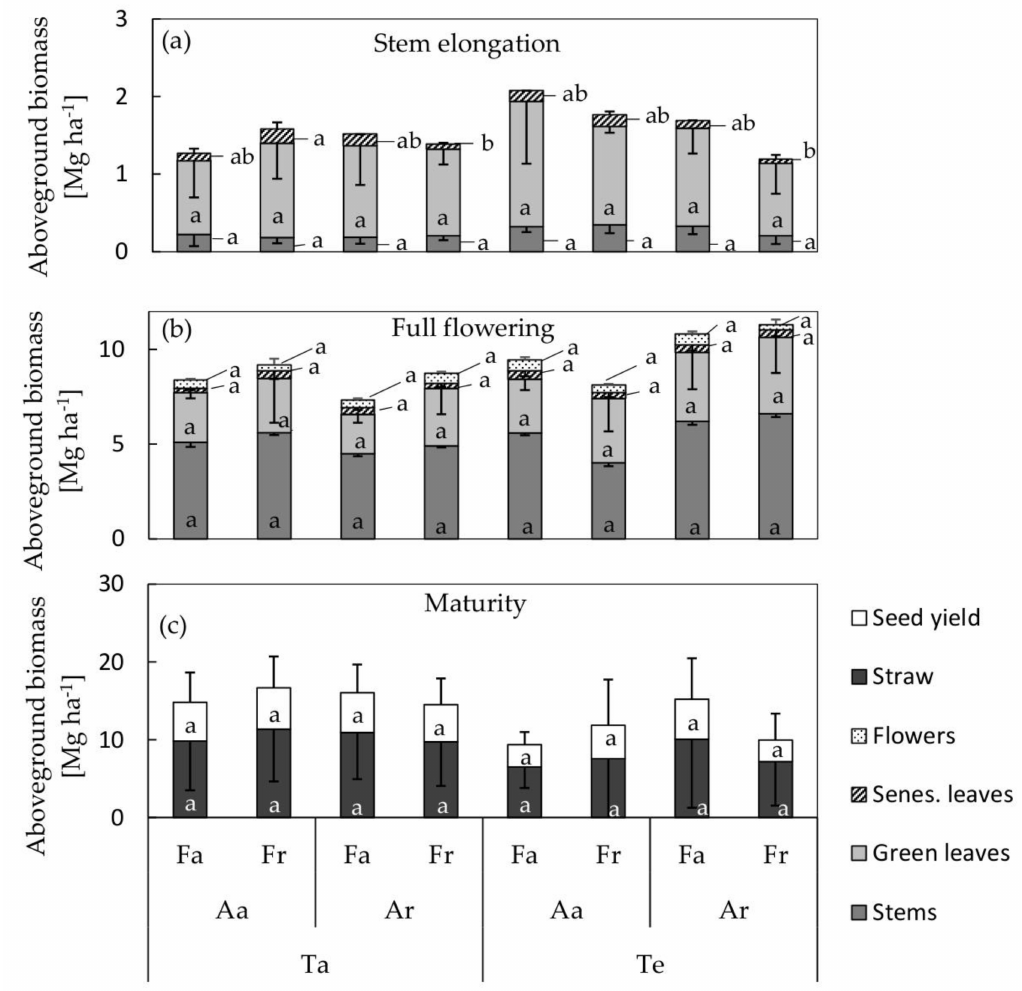
Figure 4. Aboveground biomass of OSR grown under ambient (Ta) or elevated (Te) soil temperature in combination with the following precipitation patterns: ambient (Aa) or reduced (Ar) precipitation amount and ambient (Fa) or reduced (Fr) precipitation frequency. Three harvests were performed: harvest 1 at stem elongation (DC 31) ( a ), harvest 2 at full flowering (DC 65) ( b ), and harvest 3 at maturity (DC 99) ( c ). The aboveground biomass fractions are shown as dry weight. Data are means ± standard deviations across four replicates ( n = 4). Means with the same letter indicate a non-significant di ff erence between these means based on Fishers least significant di ff erence (LSD) test. Straw contains stem and senescent leave biomass. The data originate from OSR covered by roofs. The roofs had no e ff ects on aboveground biomass of the three harvest dates. Abbreviation: Mg = megagram; ha = hectare; senes. =